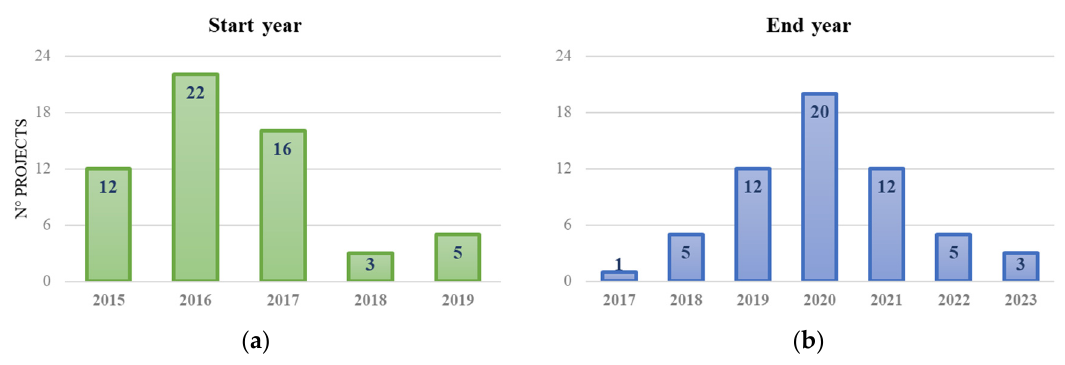
Figure 4. Number of projects per ( a ) start year and ( b ) end year.